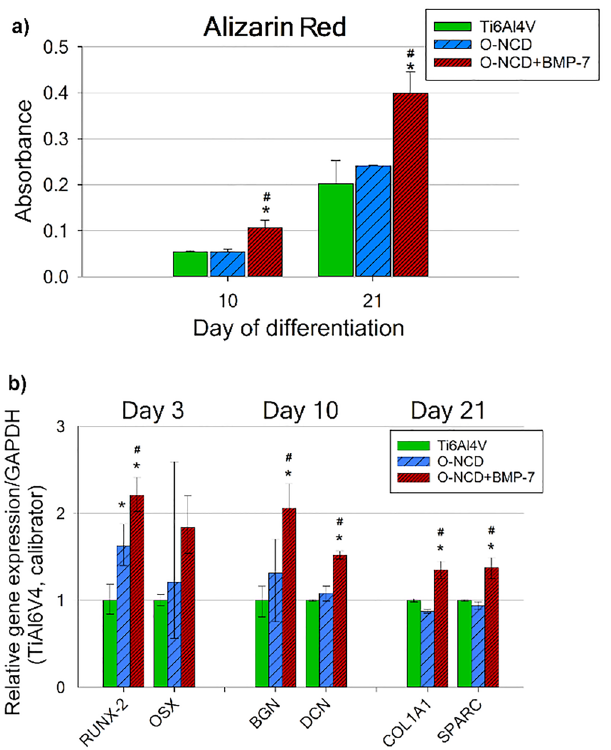
Figure 4. Mineralization of the extracellular matrix, assessed by Alizarin Red S staining, induced by hFOB 1.19 cells (a ), and their relative gene expression (b). The cells were cultured on bare Ti6Al4V samples (Ti6Al4V), on Ti6Al4V samples coated with the O-terminated nanocrystalline diamond coating (O-NCD), or on Ti6Al4V samples coated with the O-terminated nanocrystalline diamond coating functionalized with BMP-7 (O-NCD + BMP-7) under differentiation conditions (a restrictive temperature of 39.5 °C) for 3 weeks. Graph (b) compares the gene expression of osteogenic markers RUNX-2 and OSX (osterix; both early markers), BGN and DCN (biglycan and decorin; mid-term markers) and COL1A1 with SPARC (collagen type I and osteonectin; − (cid:31)(cid:31) Ct late markers). The relative mRNA expression was quantified by the 2 method. The data are expressed relative to GAPDH, normalized to gene expression on the reference Ti6Al4V sample (calibrator). Mean ± S.E.M. (a) . Mean ± SD (b) . * indicates a significant difference from the reference Ti6Al4V, while # shows a significant difference from the O-NCD coating; p <